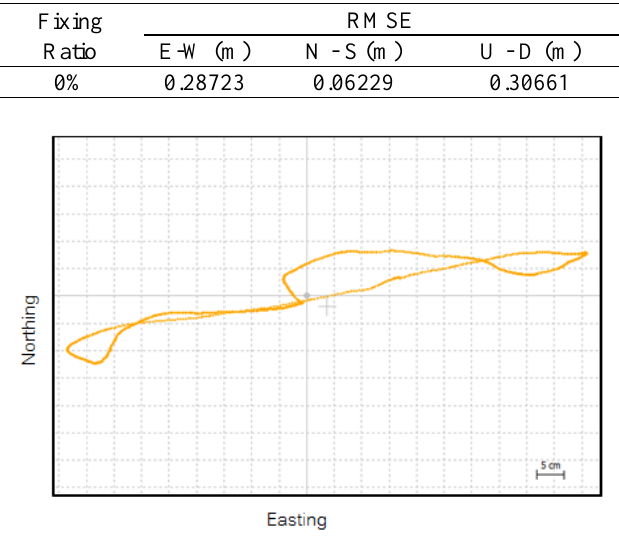
Fig. 13. Plot of the RTK horizontal position components from single frequency GPS module observation on obstructed area